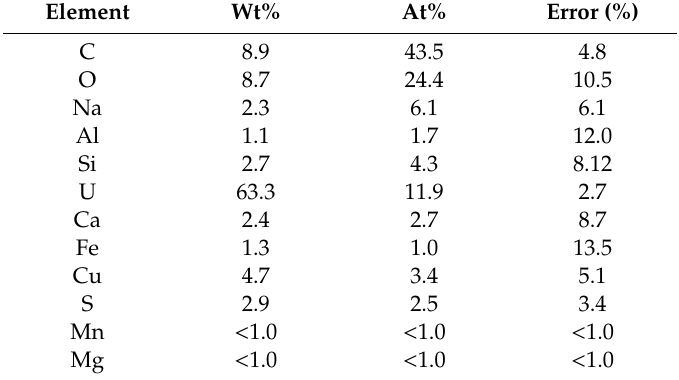
Figure 7. EDS compositional spectra of three of the mineral grains ( A – C ) identified formerly in Figure 6, showing their combined U and Cu composition, alongside the other common rock-forming constituents comprising the surrounding bulk matrix ( D , E ). The composition of these “accessory phases” ( D , E ) is subsequently elucidated via Raman spectroscopy analysis, the results of which are presented in Figure 8. Table 2. EDS elemental compositional quantification of point A identified in Figure 6c, the spectra of which is shown (alongside points B, C, D and E) in Figure